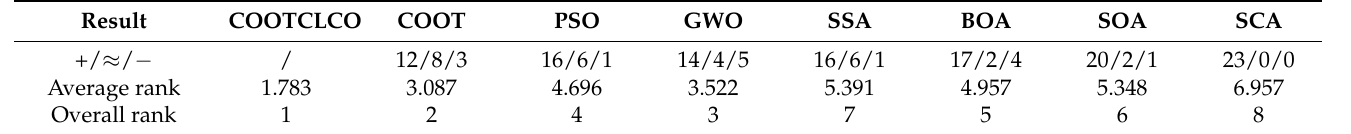
Table 8. Overall Wilcoxon signed-rank test results, average value rank results, and algorithm rank